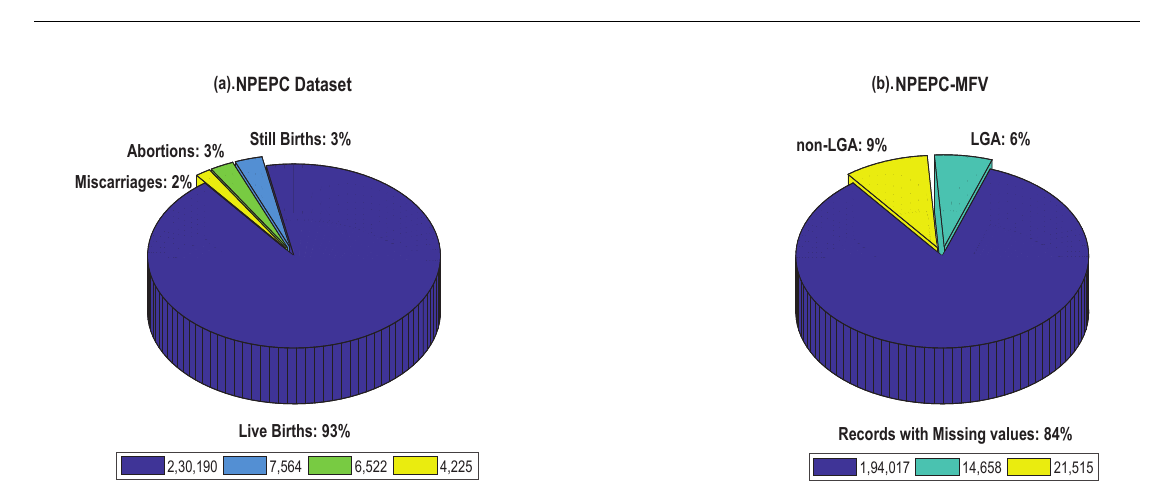
Figure 1. The details of the National Pregnancy and Examination Program of China dataset before and after applying Master Feature vector (MFV) creation algorithm where ( a ) represents the details of original Large for gestational age infants dataset and ( b ) represents the processed dataset following MFV creation